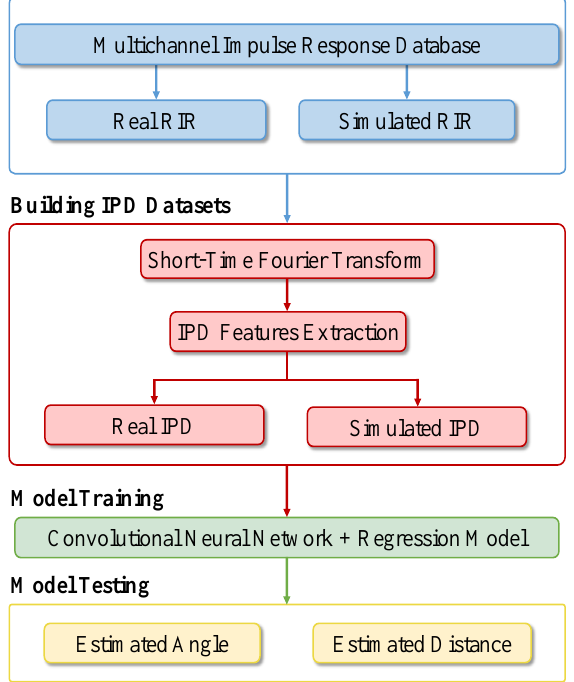
Figure 1. Flow chart of the proposed